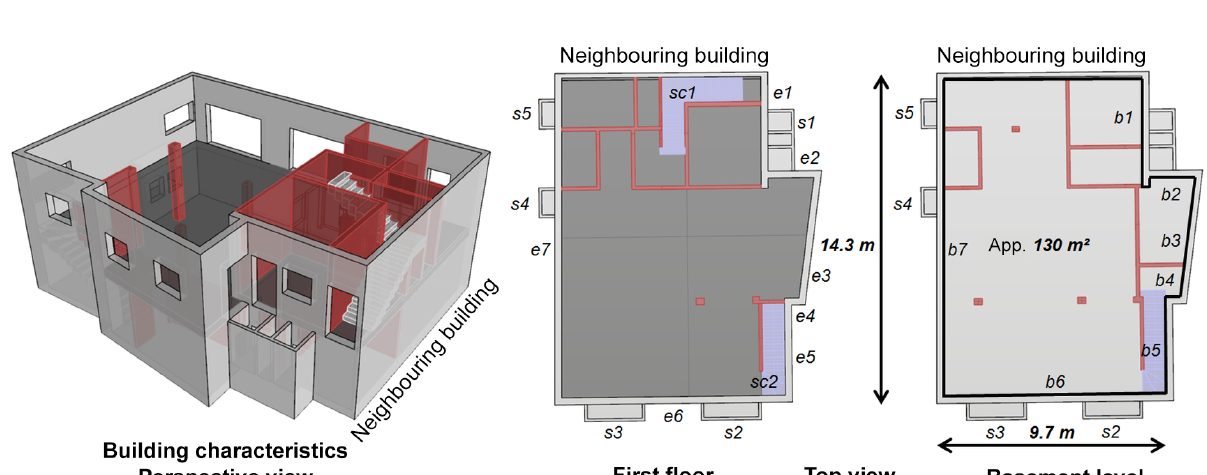
Figure 4. Object of investigation within 3-D hydrodynamic modelling – (left) perspective view and (middle, right) top views of first floor and basement level; notations e1–e7 identify exterior walls on the first floor, b1–b7 denote to corresponding wall elements on the basement level; inner walls are coloured red, s1–s5 characterise light shafts and sc1–sc2 identify stair cases (coloured blue).